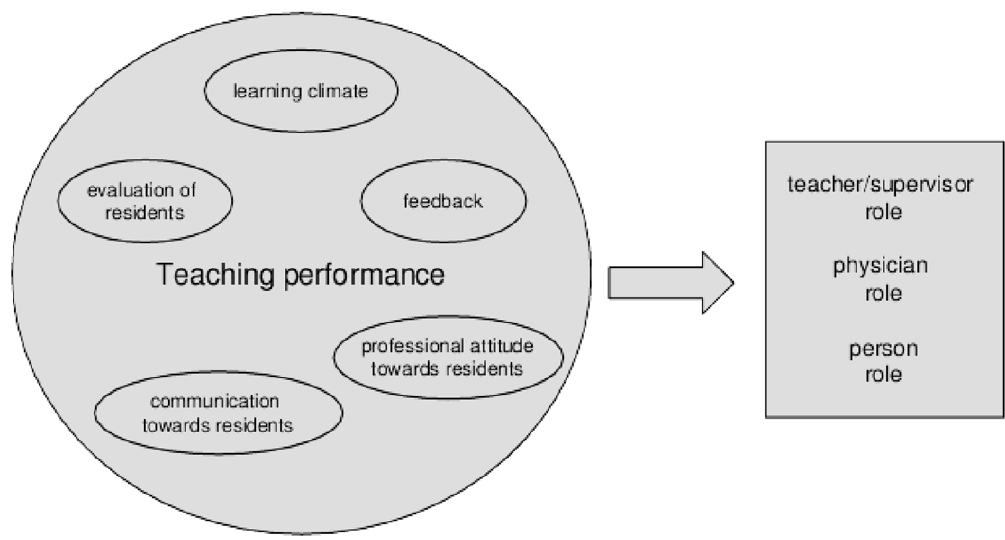
Figure 2. The predictors and outcome variables of the regression equations.